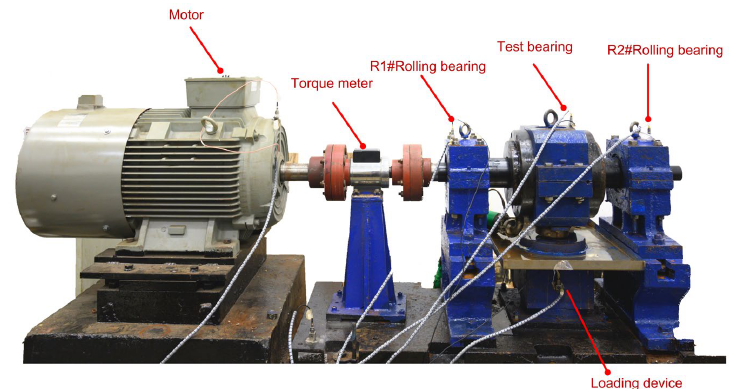
Figure 6. Physical view of the test rig.